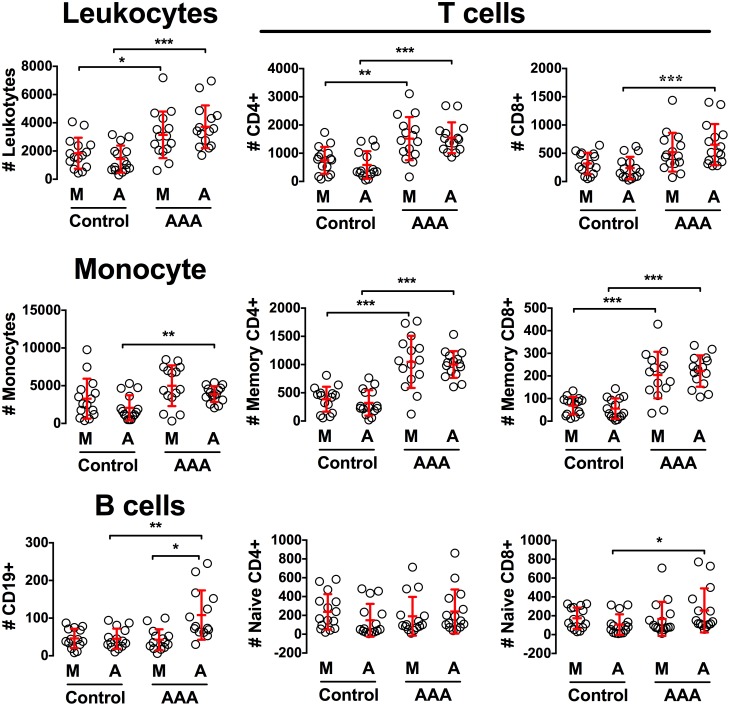
The aneurysmal aortic tissue promotes the chemoattraction of immune cells.Chemotaxis assay on conditioned medium prepared from the media (M) and adventitia (A) of AAAs (n = 15) and control aortas (n = 15). Plotted is the number of total leukocytes, monocytes, CD19+ B cells, CD44+CD62L− memory CD4+ or CD8+ T cells, CD44−CD62L+ naïve CD4+ or CD8+ T cells that have migrated toward the well containing the conditioned medium. *, p<0.05; **, p<0.01; ***, p<0.001.